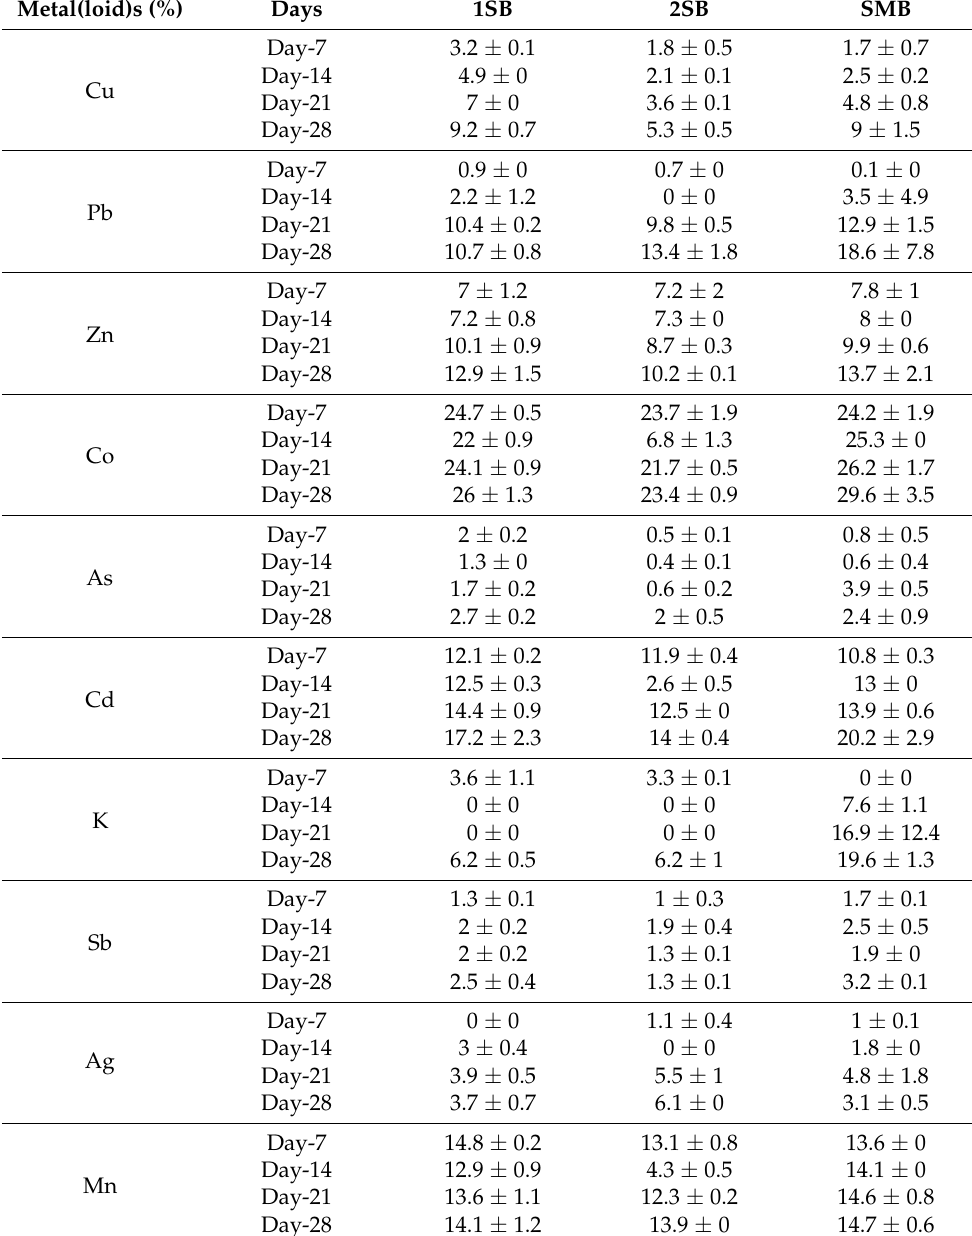
Table A5. Percentages of the metal(loid)s extracted from the Neves Corvo waste rock by the Thioclava consortium via one-step bioleaching (1SB), two-step bioleaching (2SB), and spent medium bioleaching (SMB). Values are the average of duplicate flasks ± standard